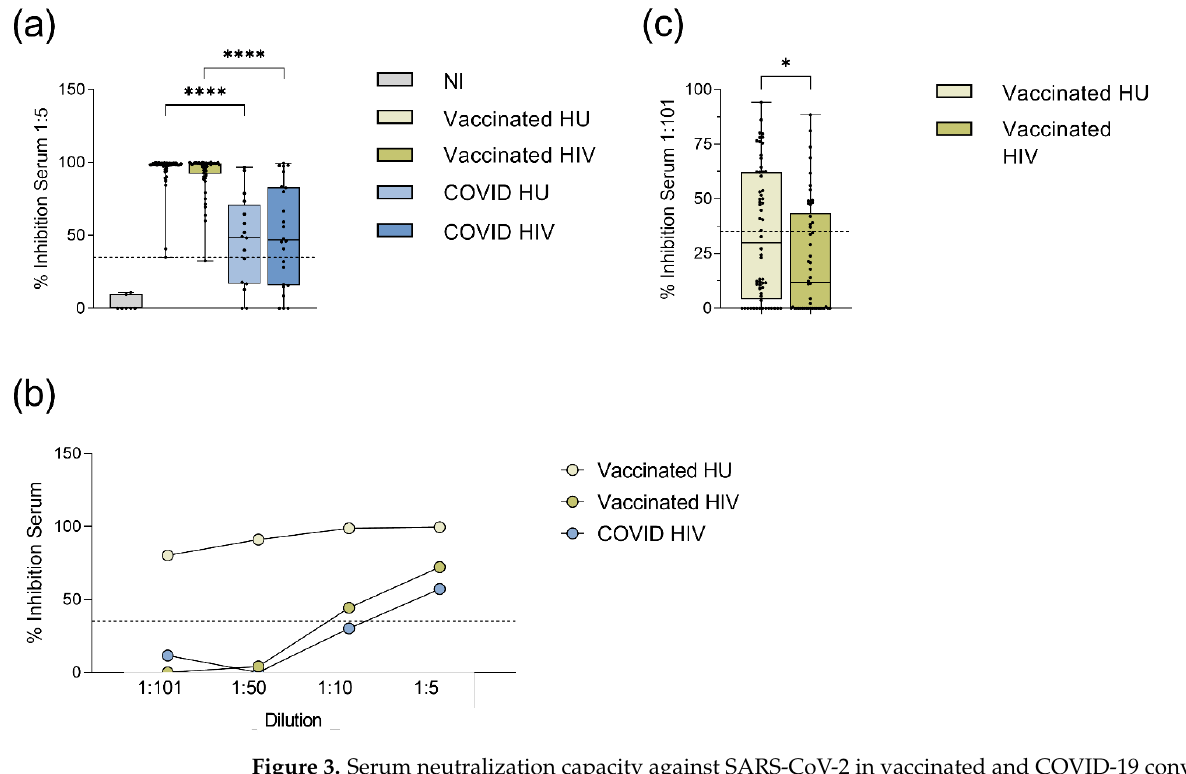
Figure 3. Serum neutralization capacity against SARS-CoV-2 in vaccinated and COVID-19 convalescent donors as measured by a surrogate ELISA neutralization assay. ( a ) Neutralizing activity in serum of the BNT162b2 mRNA vaccinated and the COVID-19 convalescent subjects at a 1:5 serum dilution. All vaccinated and convalescent groups had significantly higher neutralizing activity compared to the NI group ( p ≤ 0.0006, not depicted in the graph). Medians and IQRs are presented for SARS-CoV-2 non-immune (NI, n = 6), vaccinated HIV-1-uninfected (HU, n = 57), vaccinated HIV-1-infected (HIV, n = 50), COVID-19 HIV-1-uninfected (COVID HU, n = 16), COVID-19 HIV-1-infected (COVID HIV, n = 24). ( b ) Neutralizing activity of serial dilutions of sera from three subjects with high or low neutralization activity as determined by a 1:5 serum dilution. ( c ) Differences in serum neutralizing capacity between HIV-1-infected ( n = 50) and -uninfected vaccinated subjects ( n = 60) at a 1:101 serum dilution. Medians and IQRs are presented. Significance was tested by Mann–Whitney U tests * = p ≤ 0.05, **** = p ≤ 0.0001. The cut-off for a positive result at ≥ 35% inhibition is indicated by the dashed lines. Table 6. Multivariate linear regression analysis of serum spike-specific neutralizing antibodies at a 1:101 dilution among the SARS-CoV-2 vaccinated subjects.